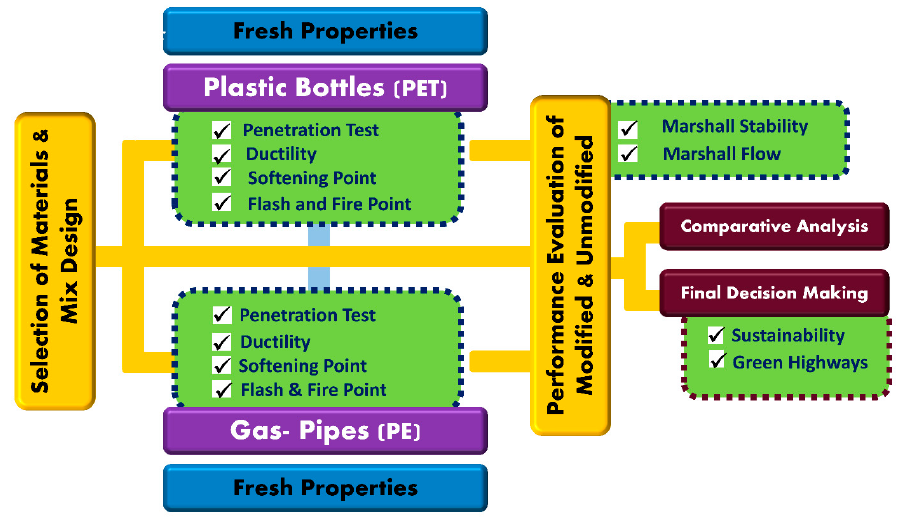
Figure 3. Flow Chart of Research Methodology .